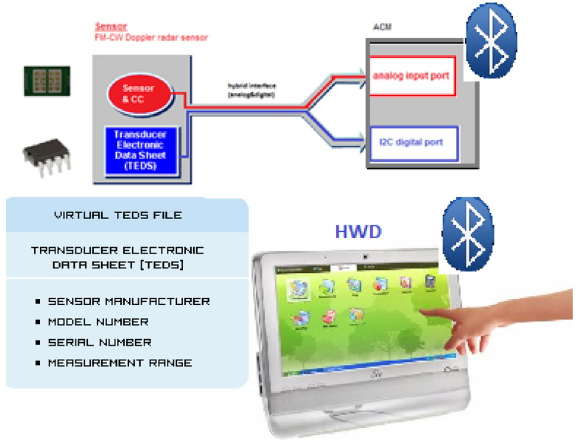
Figure 7. Smart sensor IEEE1451.4 compatible architecture (ACM = acquisition and data communication module; HWD = healthcare window